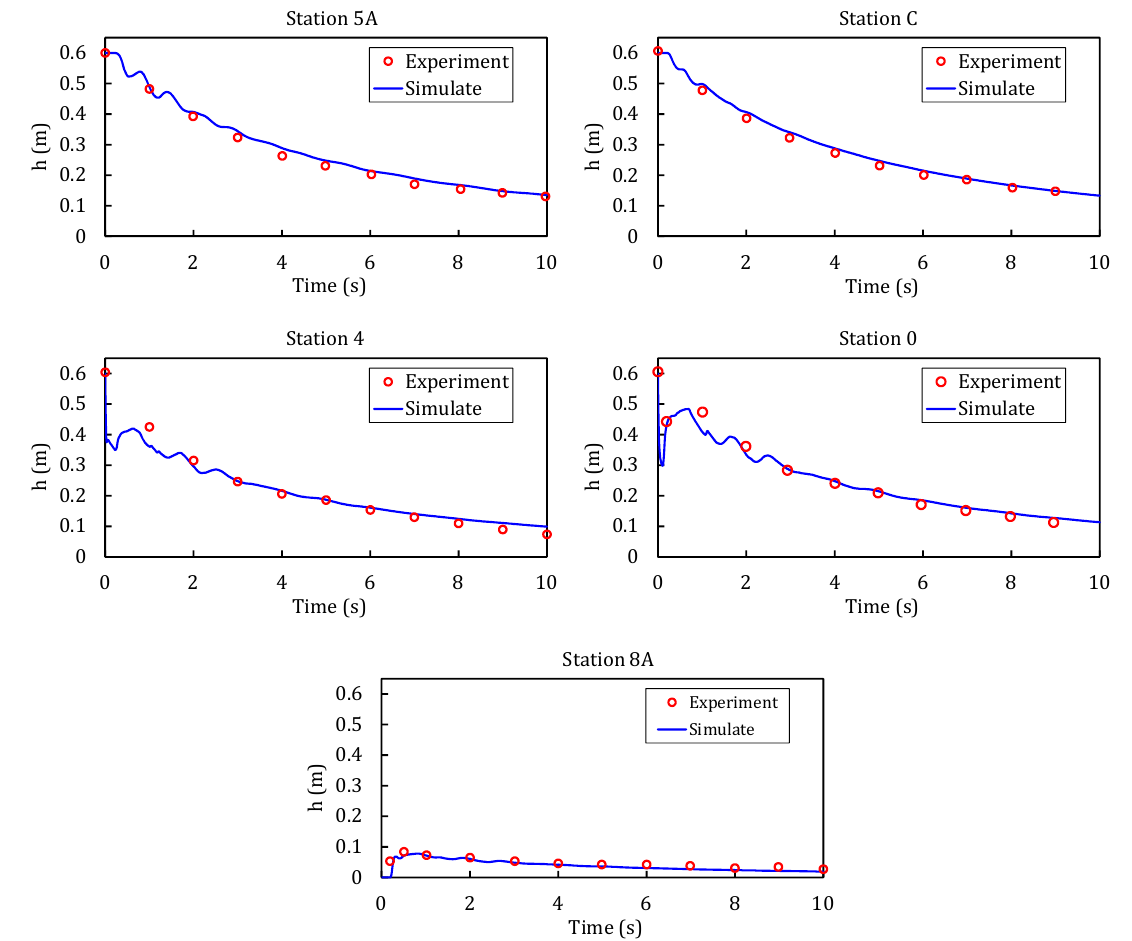
Figure 5. Comparisons between calculated and measured water depth at five gauge